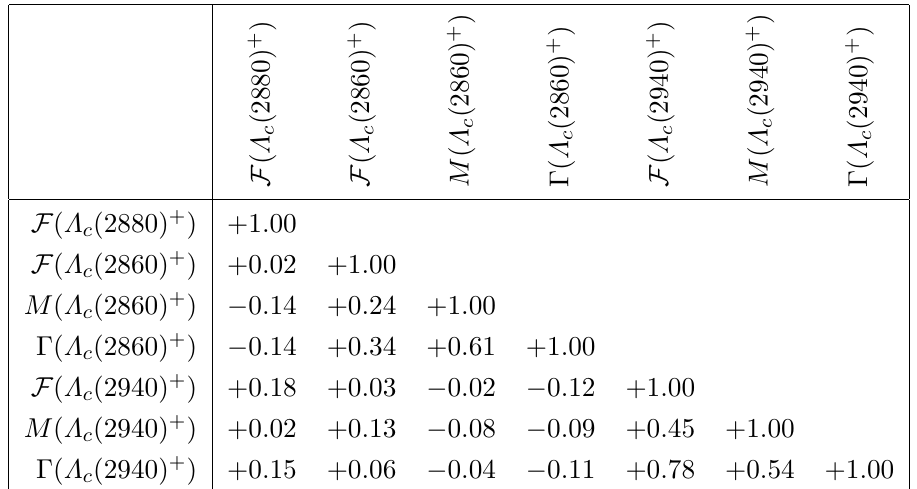
Table 7 . Correlation matrix associated to the statistical uncertainties of the (cid:12)t results in the (cid:12)t region 4.